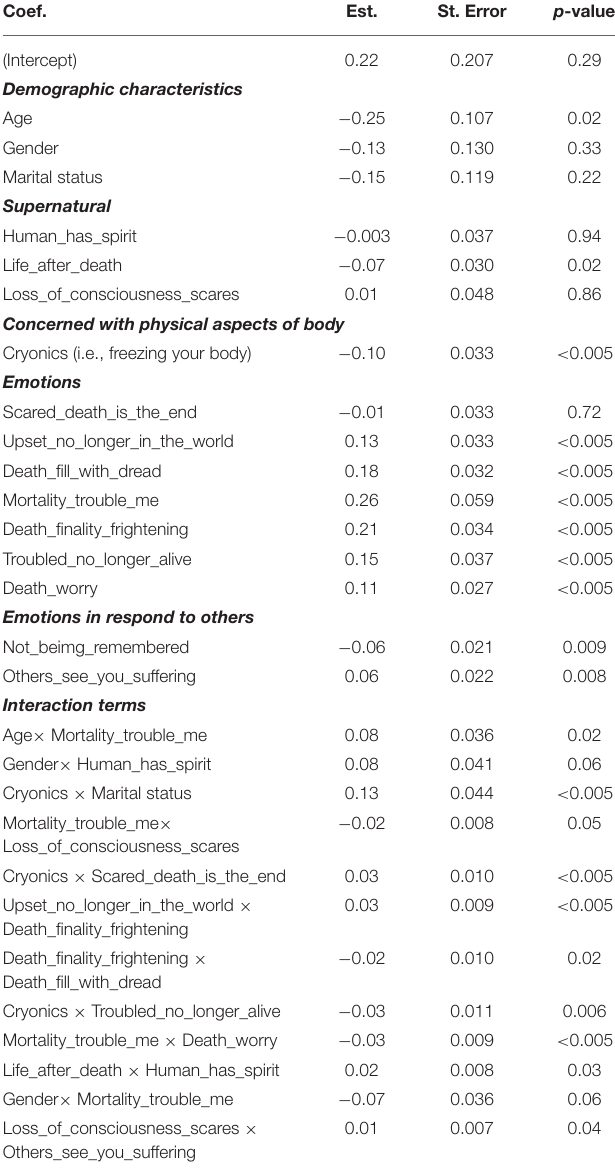
TABLE 2 | Results of statistical